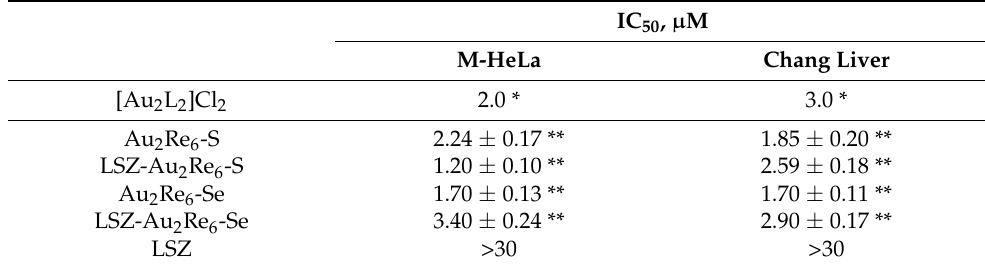
Table 2. IC 50 values determined for M-HeLa and Chang Liver cell lines after incubation by [Au 2 L 2 ]Cl 2 complex, Au 2 Re 6 -Q, and LSZ-Au 2 Re 6 -Q